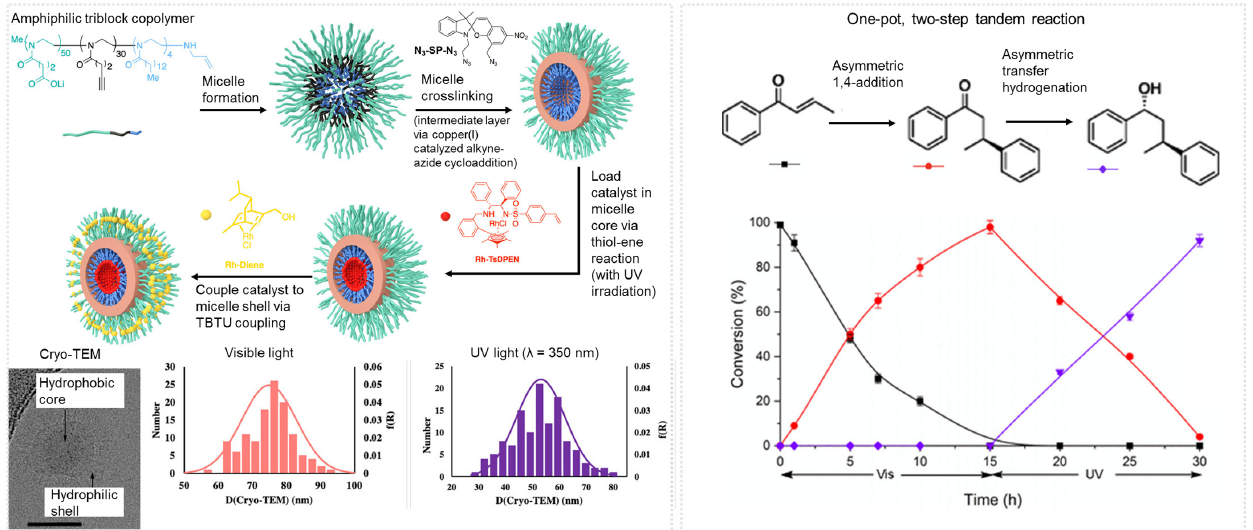
Figure 12. Amphiphilic triblock copolymers comprising a carboxylic acid salt-based hydrophilic block, a cross-linkable middle block containing a terminal alkyne, and a hydrophobic block containing an alkyl tail and a terminal allylamine for modification in the micellar core. Following micelle formation in water, the micelles were cross-linked using copper(I)-catalyzed alkyne-azide cycloaddition between the alkyne moiety and bifunctionalized spiropyran (N 3 -Sp-N 3 ). A core–shell structure was observed by cryogenic TEM (cryo-TEM) (50 nm scale bar). The micelles were exposed to visible light ( λ = 550 nm) for 15 min and to UV irradiation ( λ = 350 nm) for 15 min. Upon irradiation with UV light, the diameter decreased from 70 nm to 58 nm (statistical size distribution is based on a sample size of at least 120 micelles). Two chiral Rh catalysts were immobilized in two separate microenvi- ronments via orthogonal chemistries. First, the alkene functionalities in the core were reacted with a multivalent tetrathiol linker through thiol–ene click chemistry. A second hydroxy-functionalized Rh–diene complex was attached along the side chains of the shell via o-(benzotriazol-1-yl)- N , N , N (cid:48) , N (cid:48) - tetramethyluronium tetrafluoroborate (TBTU)/ N , N -diisopropylethylamine (DIPEA)-mediated cou- pling. The reversible, photo-switchable behavior was retained after catalyst immobilizations. One-pot, two-step tandem reaction involving asymmetric 1,4 addition of phenylboronic acids to the trans -1- phenyl-2-buten-1-one reaction that occurs in the micelle shell was followed by Rh-TsDPEN-catalyzed ATH of ( S )-1,3-diphenylbutan-1-one to yield the desired product, (1 R ,3 S )-1,3-diphenyl-1-butanol,